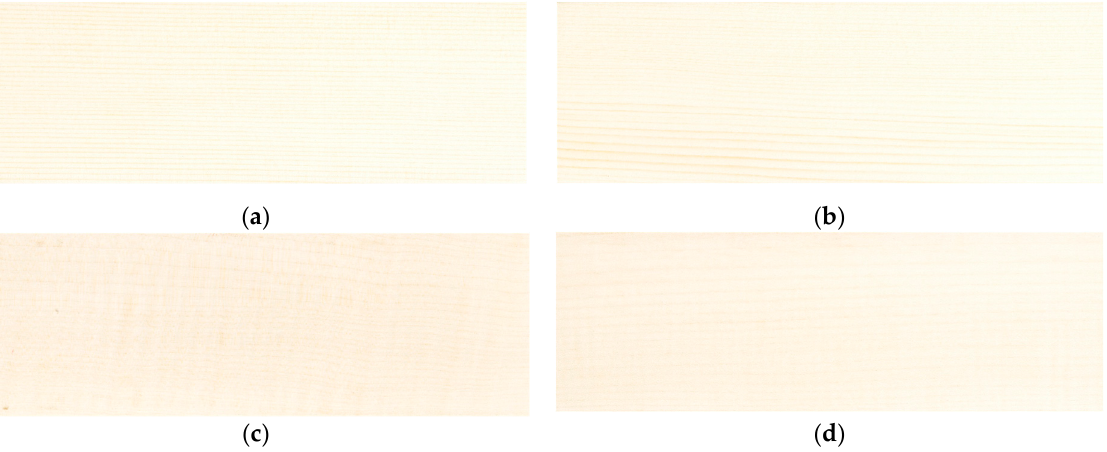
Figure 1. The types of samples studied: ( a ) spruce samples, grade A; ( b ) spruce samples, grade D; ( c ) sycamore maple samples, grade A; ( d ) sycamore maple samples, grade D. ( c ) sycamore maple samples, grade A; ( d ) sycamore maple samples, grade